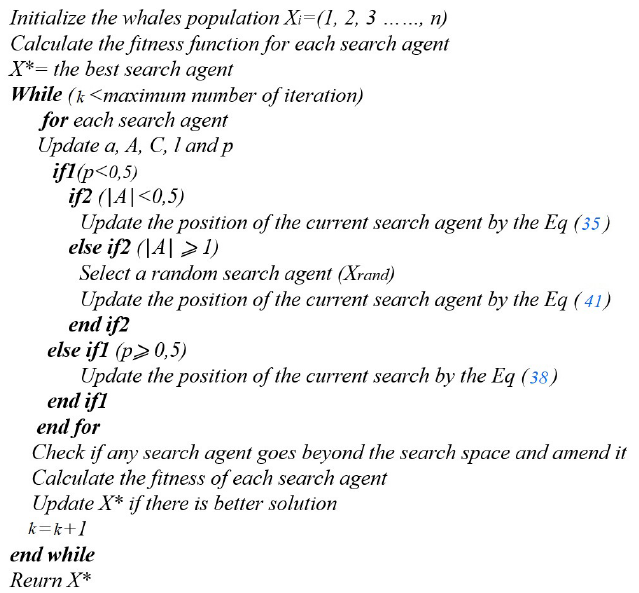
Figure 9. WOA pseudo-code.